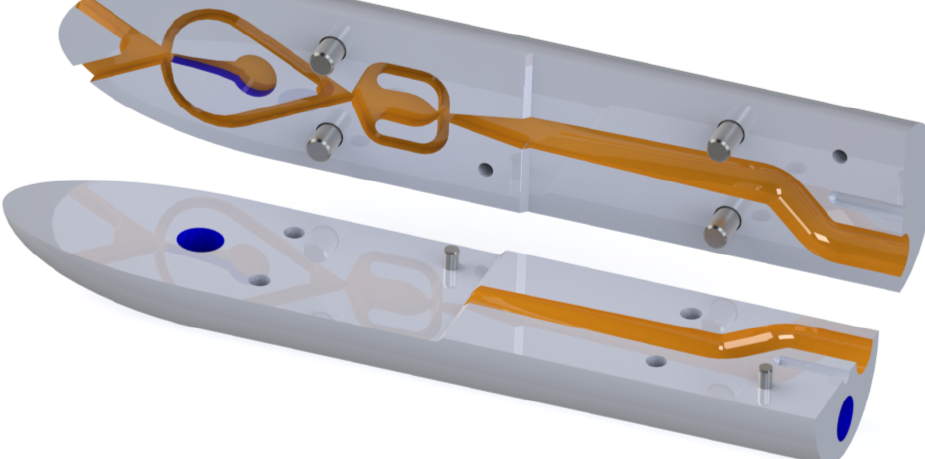
Figure 10. Two-part design stainless steel actuator for application in a combustion